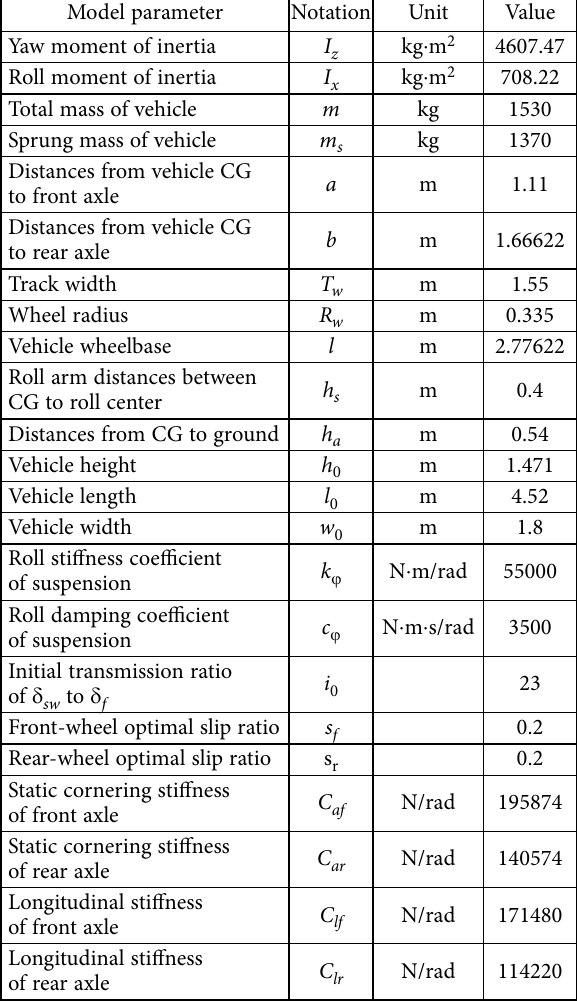
Table 2. Parameters of a D-class sedan Model